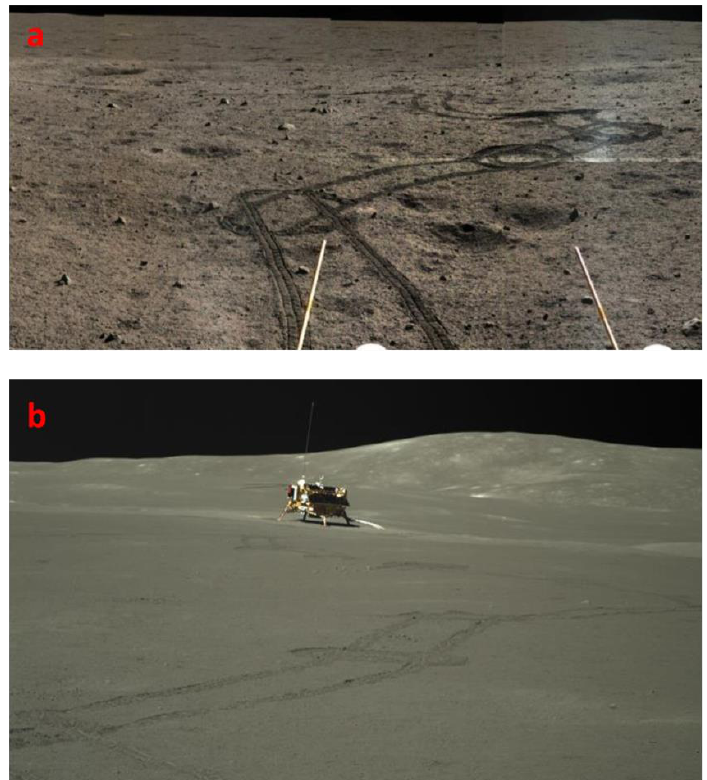
Figure 9. ( a ) This is the topography and geomorphology of CE-3 landing site. ( b ) This is the topography and geomorphology of CE-4 landing site.